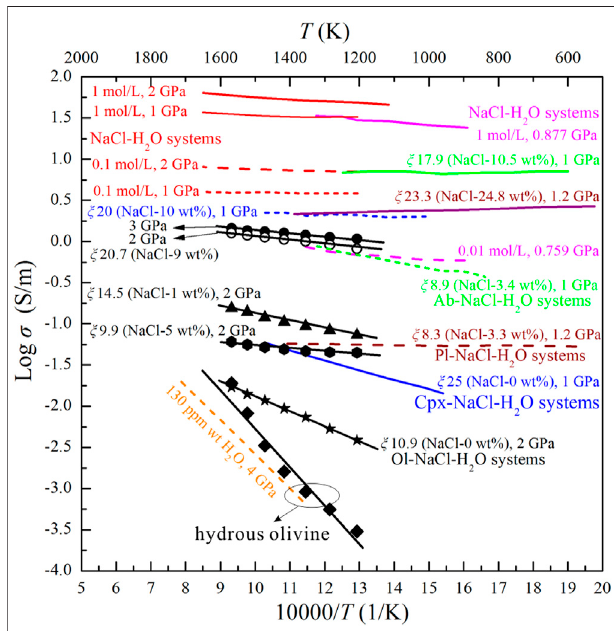
FIGURE 7 | Electrical conductivities of hydrous olivine aggregates and the Ol – H 2 O and Ol – NaCl – H 2 O systems in this study and relevant systems from previous studies. The dashed orange line indicates the conductivities of the hydrous olivine aggregates (Dai and Karato, 2014b). The purple fi ve- pointed star indicates the conductivity of saline fl uids-bearing forsterite aggregates (Huang et al., 2021). The solid and dashed blue lines indicate the conductivitiesoftheCpx – H 2 OandCpx – NaCl – H 2 Osystems(Sunetal.,2020), respectively. The dashed and solid brown lines indicate the conductivities of the Pl – NaCl – H 2 O systems (Li et al., 2018). The dashed and solid green lines indicate the conductivities of the Ab – NaCl – H 2 O systems (Guo et al., 2015). The red and pink lines indicate the conductivities of NaCl – H 2 O systems (Sinmyo and Keppler, 2017; Guo and Keppler, 2019). The relationships between the logarithmic conductivities of the various hydrous olivine aggregates and saline fl uid-bearing systems and reciprocal temperature are distinguished in different